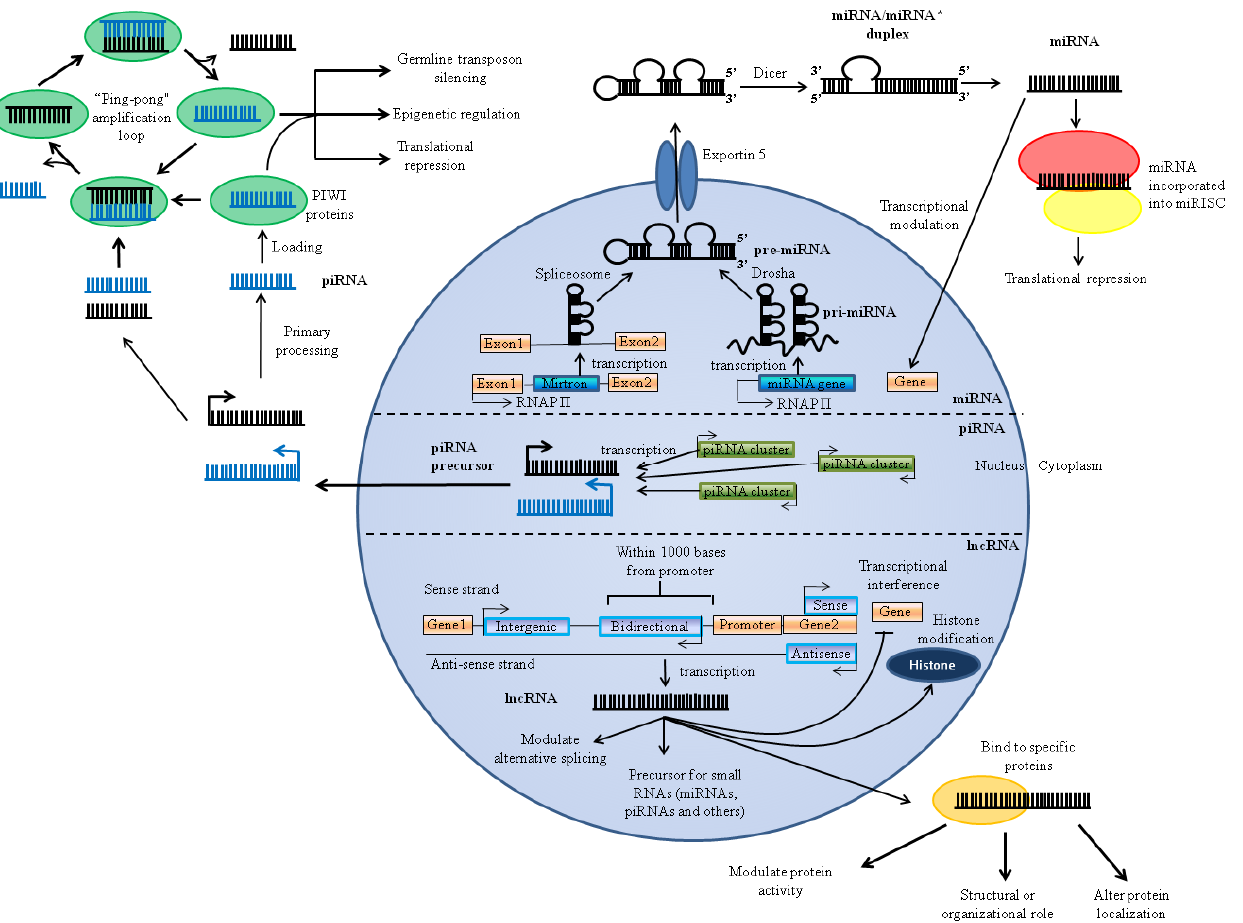
Figure 1. Biogenesis and function of the major ncRNAs (miRNAs, piRNAs, lncRNAs) implicated in ischemic